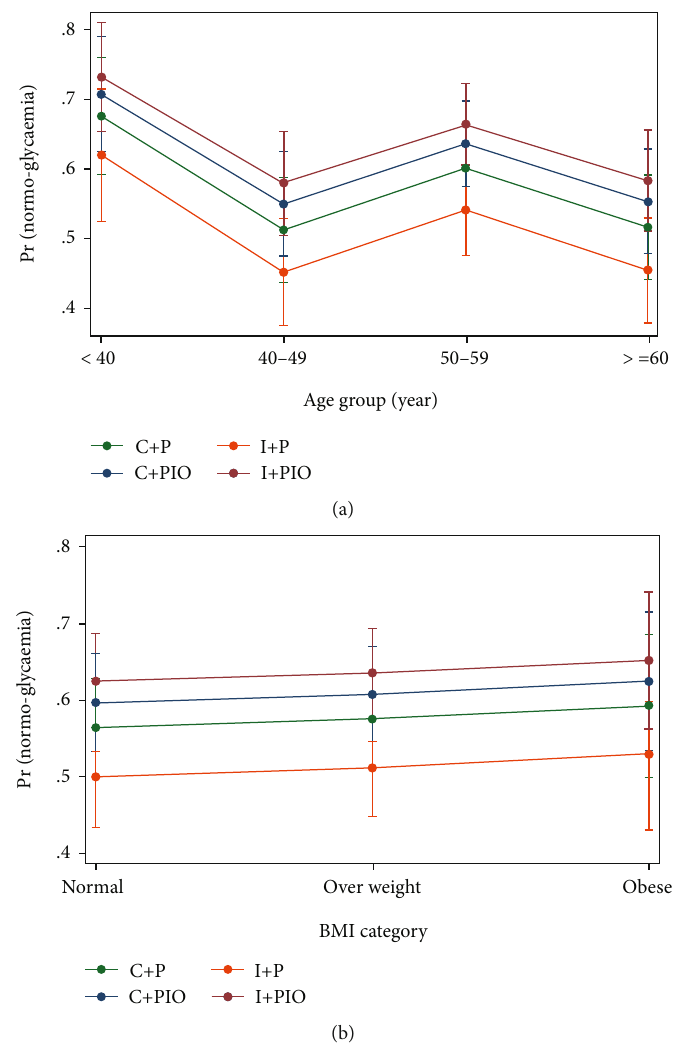
Figure 2: Estimated probability of reaching normoglycemia during three years of follow-up by the treatment group: (a) separately for di ff erent age groups at baseline and (b) separately for di ff erent BMI categories at